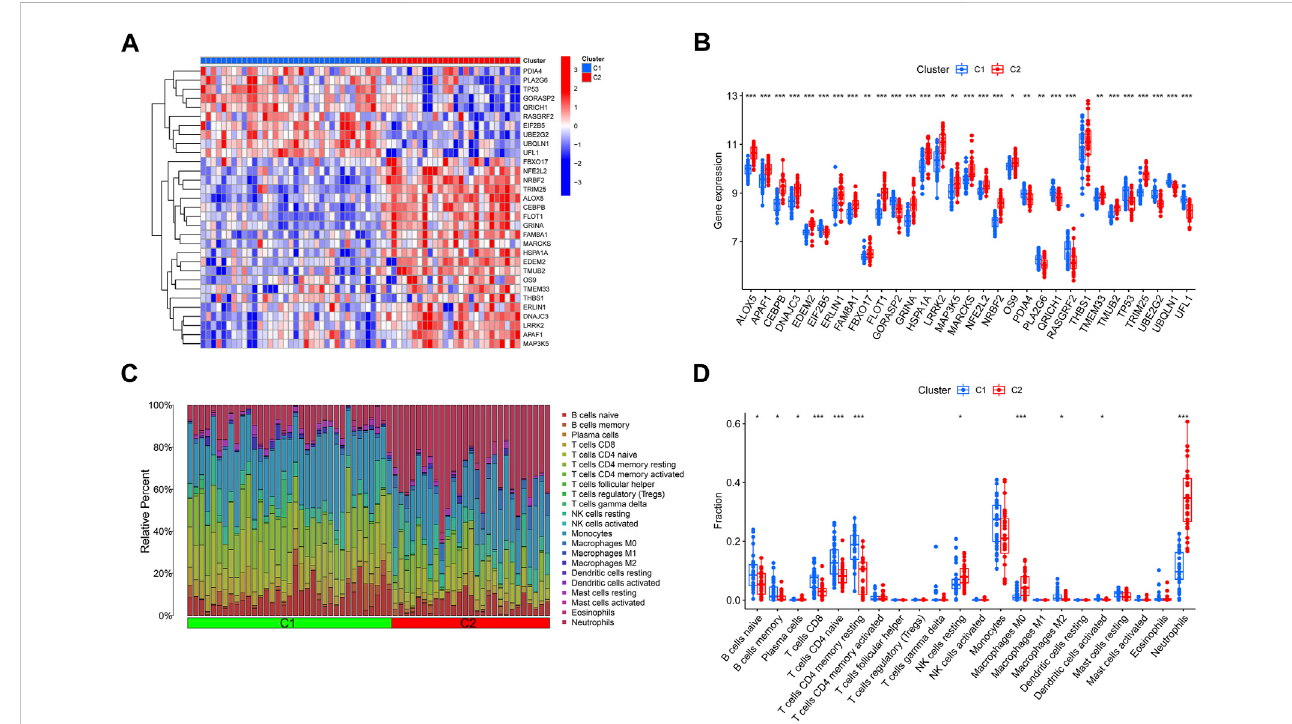
FIGURE 4 Identi fi cation of molecular and immune characteristics between the two ER stress clusters. (A) Expression patterns of DE-ERSGs between two ER stress clusters were presented in the heatmap. (B) Boxplots showed the expression of DE-ERSGs between two ER stress clusters. (C) The relative abundances of 22in fi ltratedimmunecellsbetweentwoERstressclusters. (D) Boxplotsshowedthedifferencesinimmunein fi ltratingbetweentwoERstressclusters.* p < .05, ** p < .01, *** p <